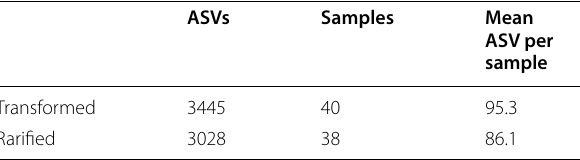
Table 1 Comparison between amplicon sequence variant (ASV) preprocessing of the original 4339